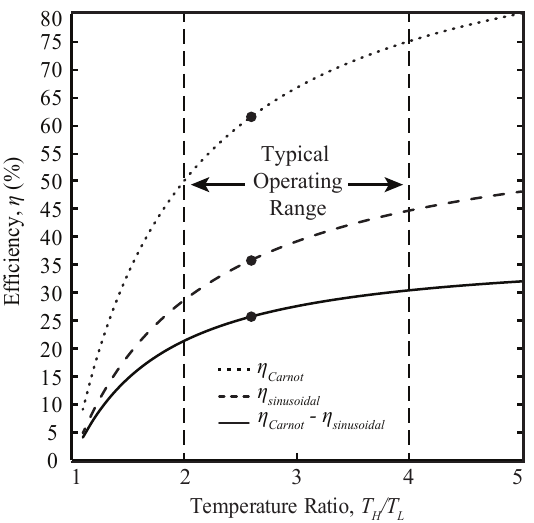
Figure 9. Efficiencies for Carnot, the sinusoidal cycle, and the deviation between them for both beta and gamma-type Stirling engines at various temperature ratios. The point indicates the values corresponding to the engine details provided in Table